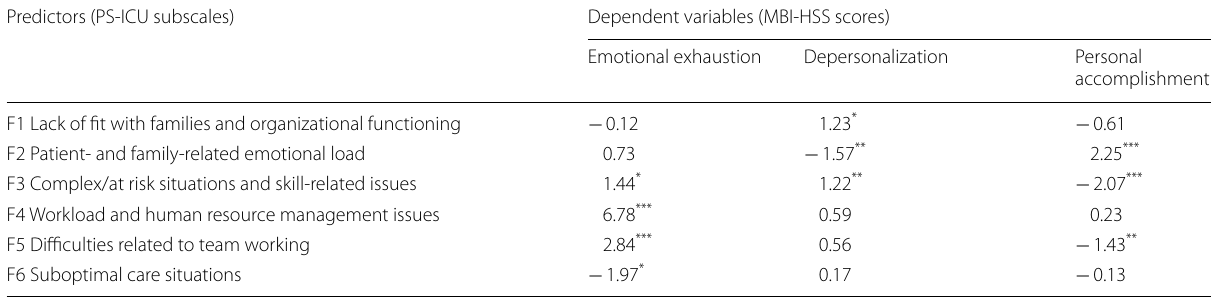
*** p < 0.001; ** p < 0.01; * p < 0.05